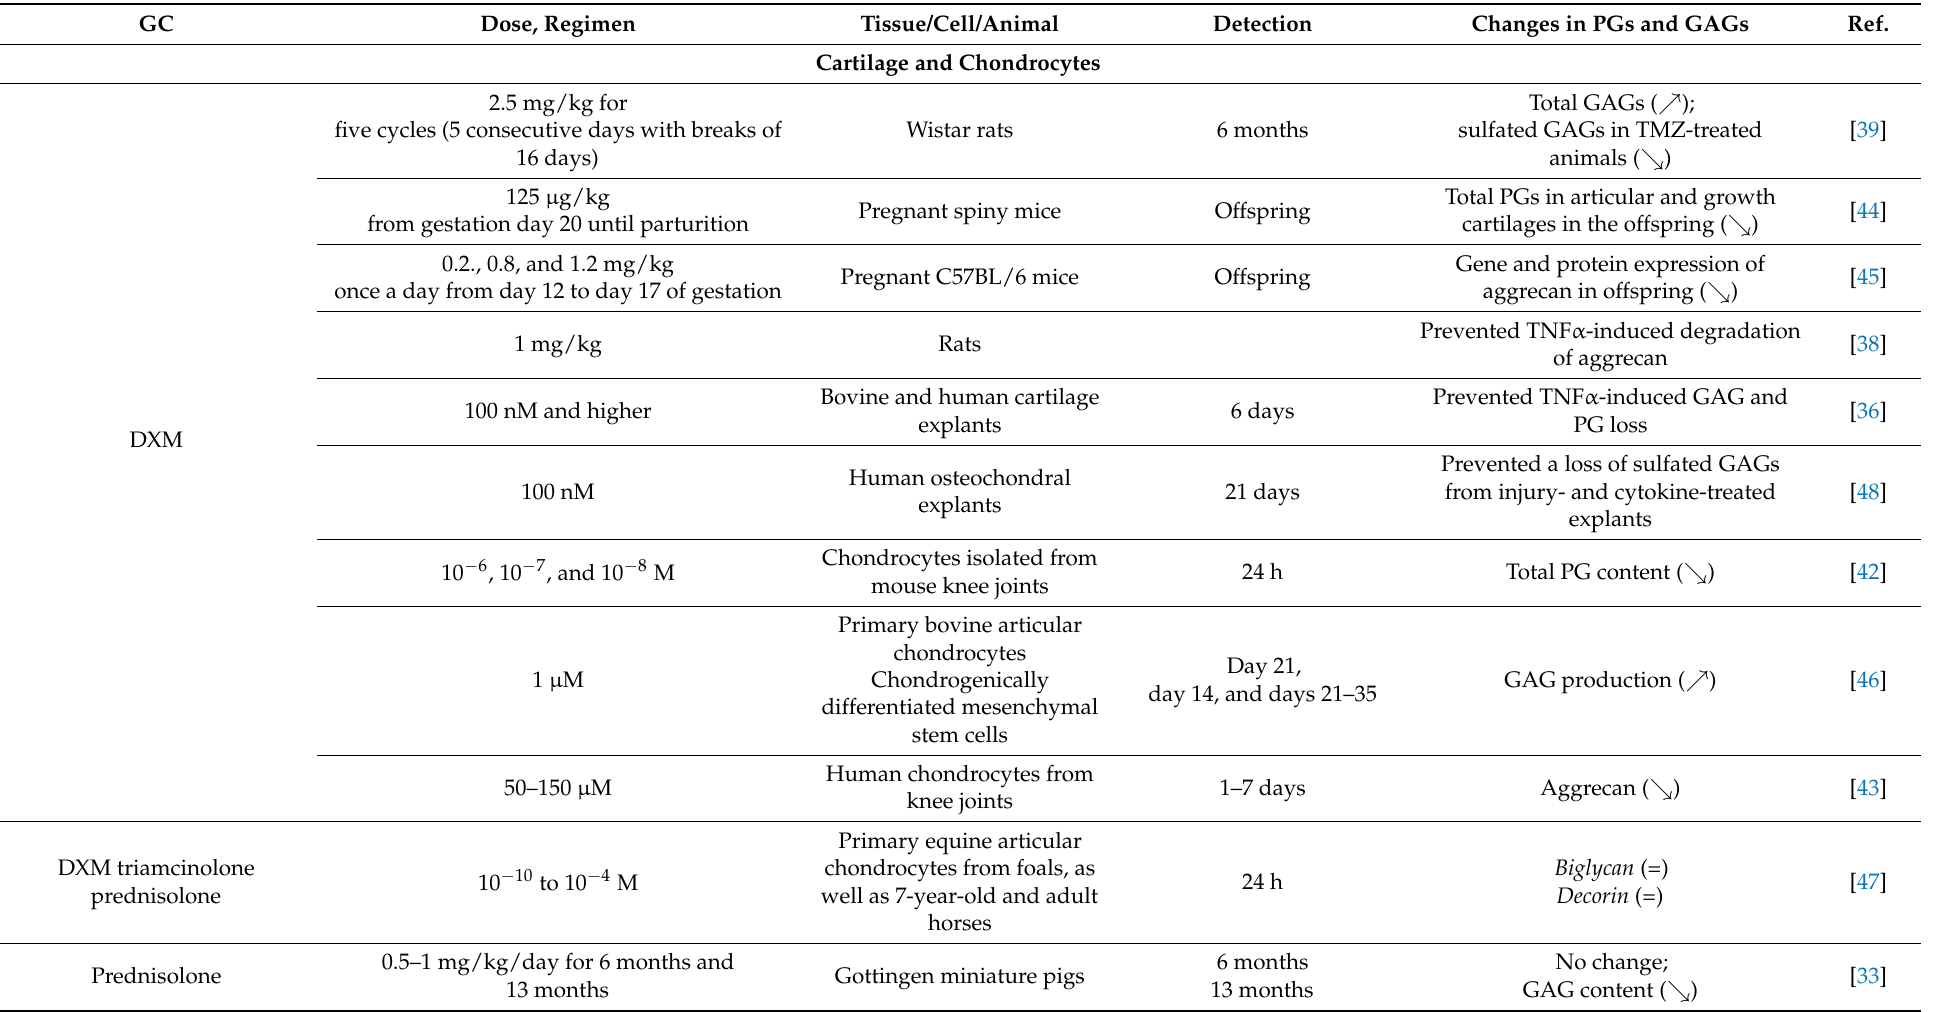
Table 1. Effects of glucocorticoids on PG expression and GAG content in normal tissues and cells. Arrows correspond to upregulation ( (cid:37) ) or downregulation ( (cid:38) )